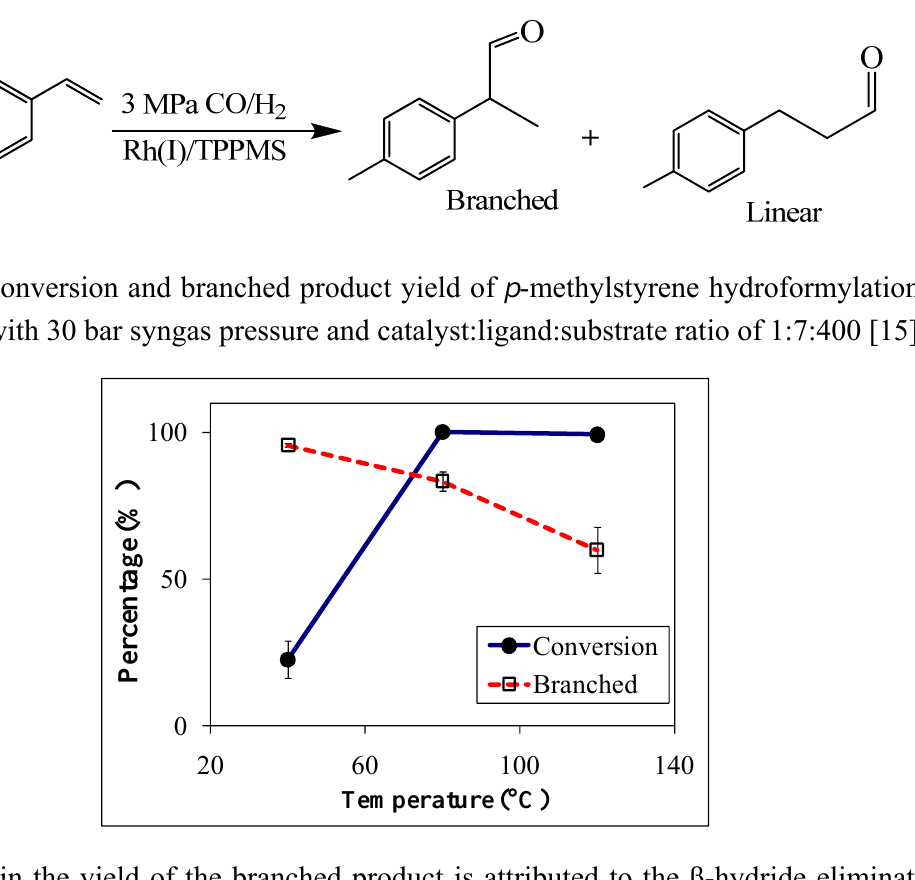
Scheme 2. Hydroformylation of p -methylstyrene in OATS.